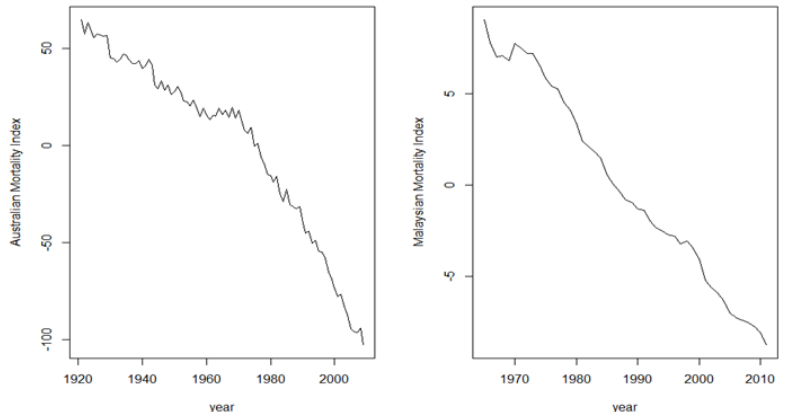
Figure 1. The mortality index, or time component, K t , estimated from the Lee–Carter model for the Australian total population from 1921 to 2009 ( left ) and for the Malaysian total population from 1965 to 2011 ( right